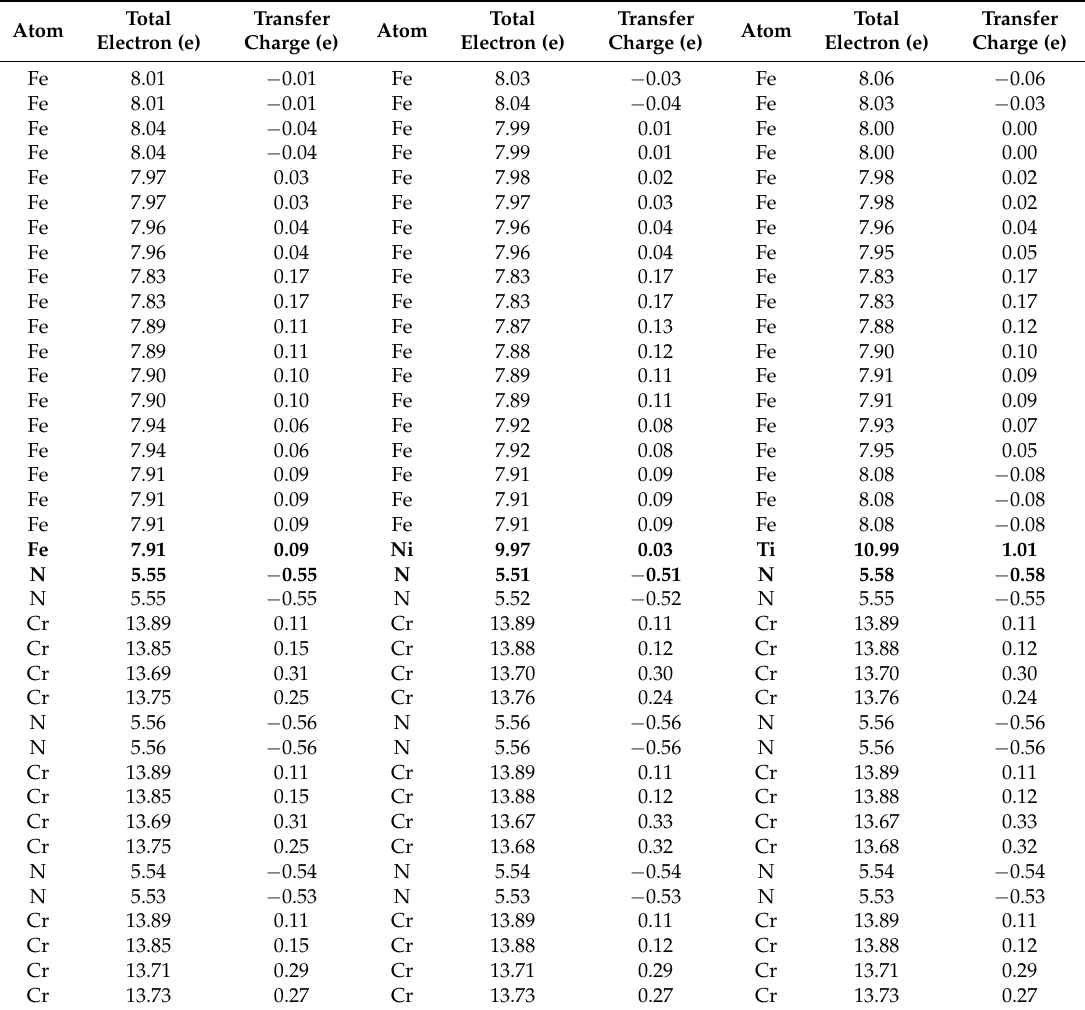
Table 3. Atomic charges on the Fe, Cr, M (M = Ti, Ni), and nitrogen atoms of clean interface, Ti-additive and Ni-additive systems calculated from Mulliken population